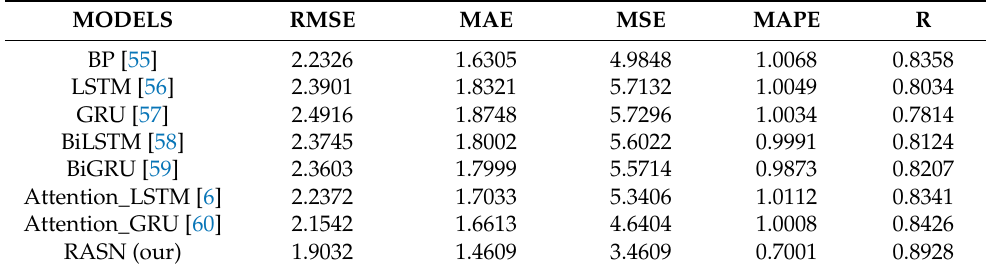
Table 2. Comparison of model prediction performance based on temperature data.